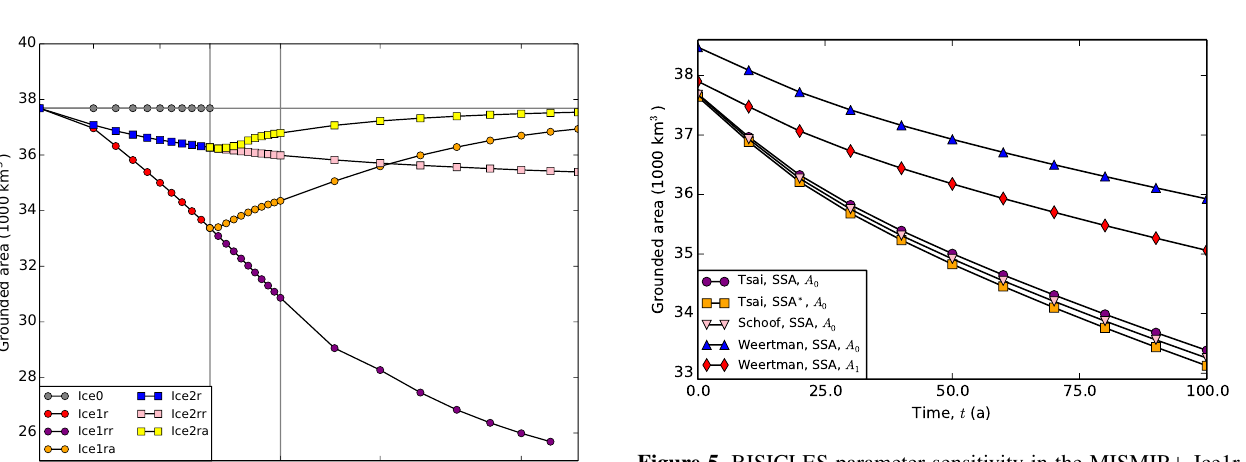
Figure 5. BISICLES parameter sensitivity in the MISMIP + Ice1r experiment. The Tsai et al. (2015) and Schoof (2005) basal-traction laws lead to similar initial states and rates of retreat, as do the SSA and SSA ∗ stress approximations, given the same rate factor A 0 = 2 . 0 × 10 − 17 Pa − 3 a − 1 . On the other hand the, the Weertman basal- traction law results in a grounding line some way upstream given the same rate factor, a closer grounding line when the rate factor is increased to A 1 = 2 . 2 × 10 − 17 Pa − 3 a − 1 , and a far slower rate of retreat in either